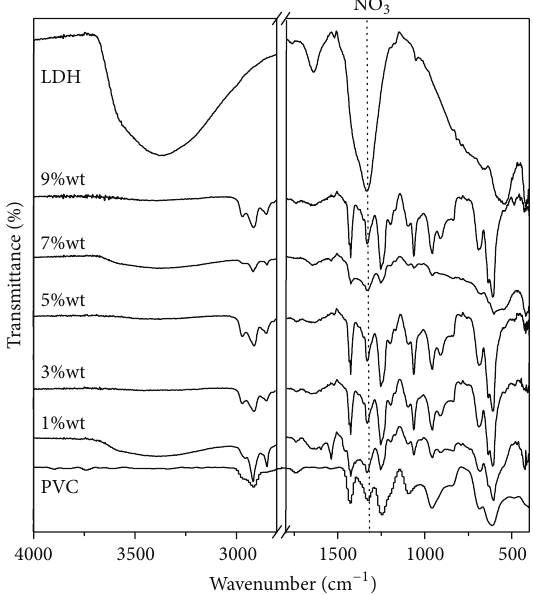
Figure 3: FTIR study of polyvinyl chloride-Zn/Al-NO 3 at varying compositions of LDH.